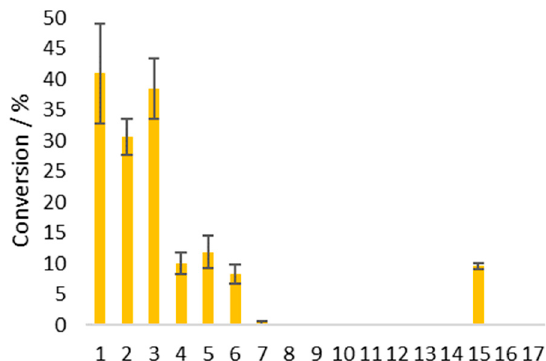
Figure 3. Conversion of probe 1 (1 mM) to aminoferrocene 4 60 min after the addition of phosphine in MeCN:H 2 O (3:1, 1M) at 50 ◦ C. Error bars represent the standard deviation, where n = 3. (1) PPh 3 ;